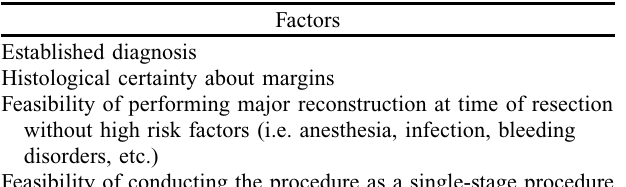
Table 2. Factors influencing the choice of immediate-definitive extremity